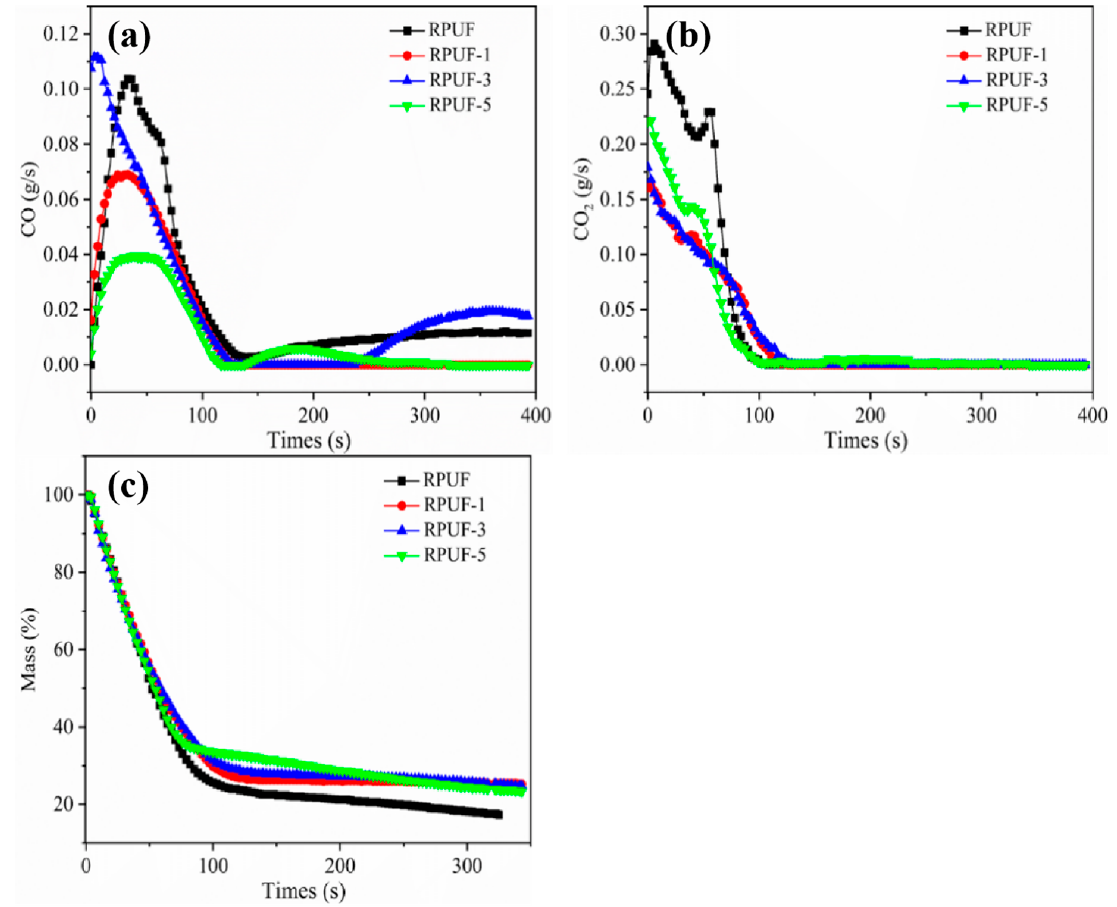
Figure 4. ( a ) CO, ( b ) CO 2 , and ( c ) Mass curves of RPUF and RPUF-R composites.